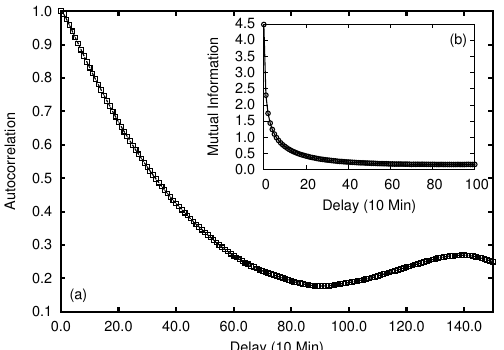
Figure 4. The fraction of false nearest neighbours as a function of Fig. 4. The fraction of false nearest neighbours as a function of the embedding dimension m for the time series of wind speed with the embedding dimension m for the time series of wind speed with τ =85 , showing that any m 14 can be considered optimal. τ = 85, showing that any m ≥ 14 can be considered optimal. 4 ≥